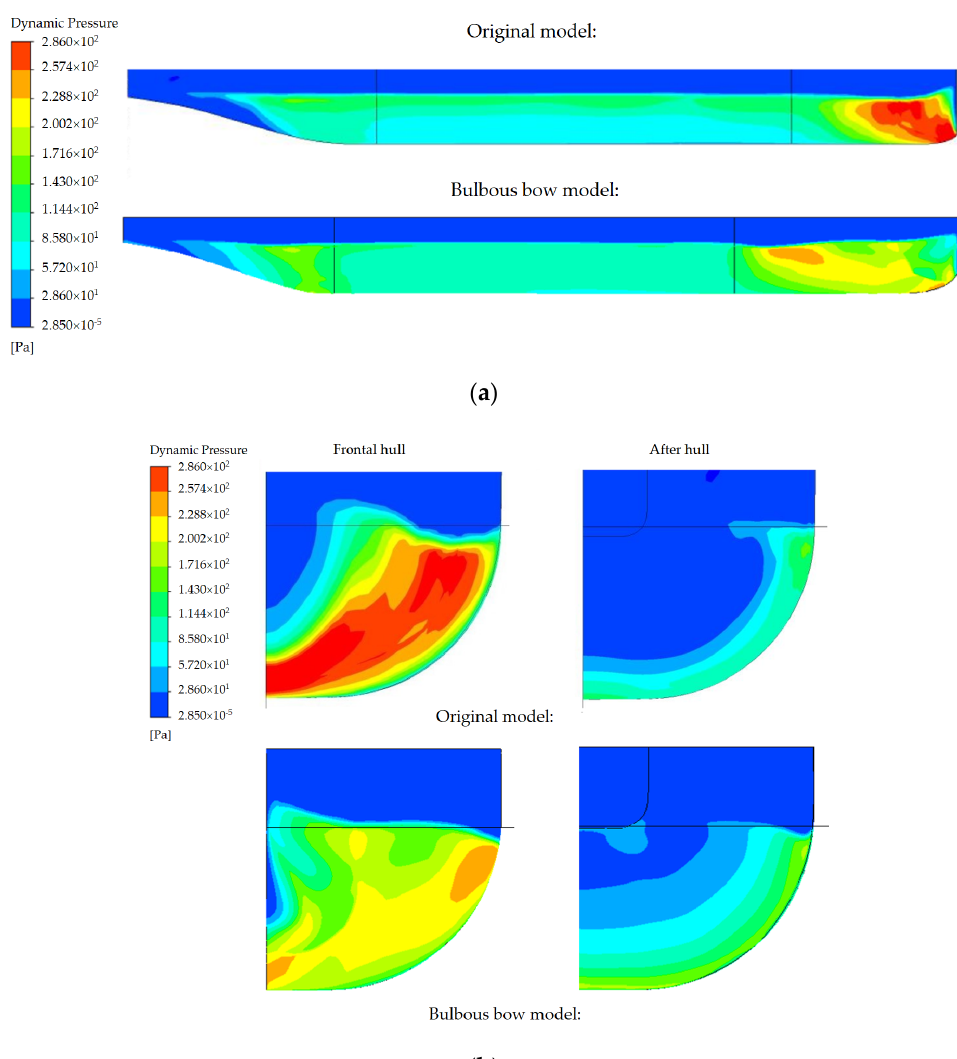
Figure 8. CFD results of dynamic pressure distribution over the surface of the ship’s hulls at F n =0.163 in calm water conditions. ( a ) Side view; ( b ) frontal and aft view.